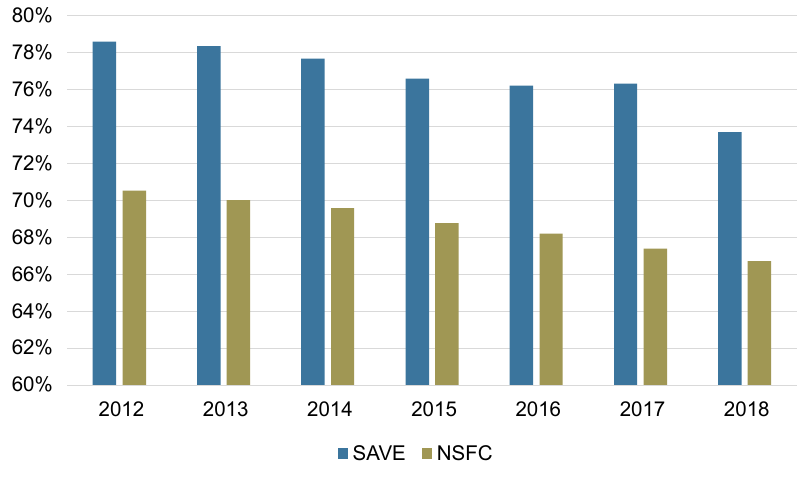
Figure A1. The proportion of the WAP in rural China. Source: SAVE data and the